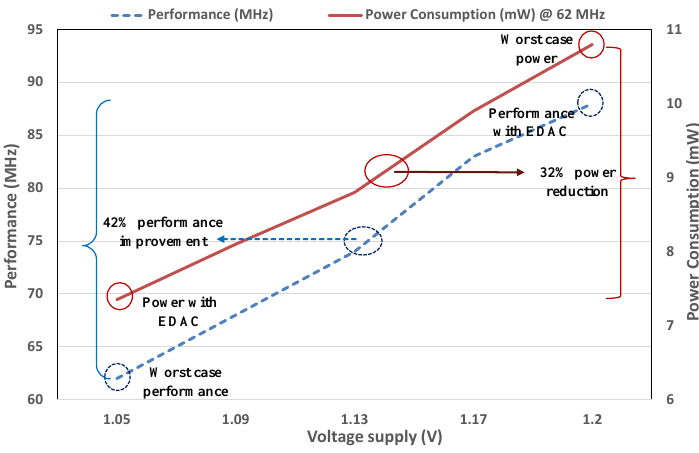
Figure 10. Performance and power consumption of the